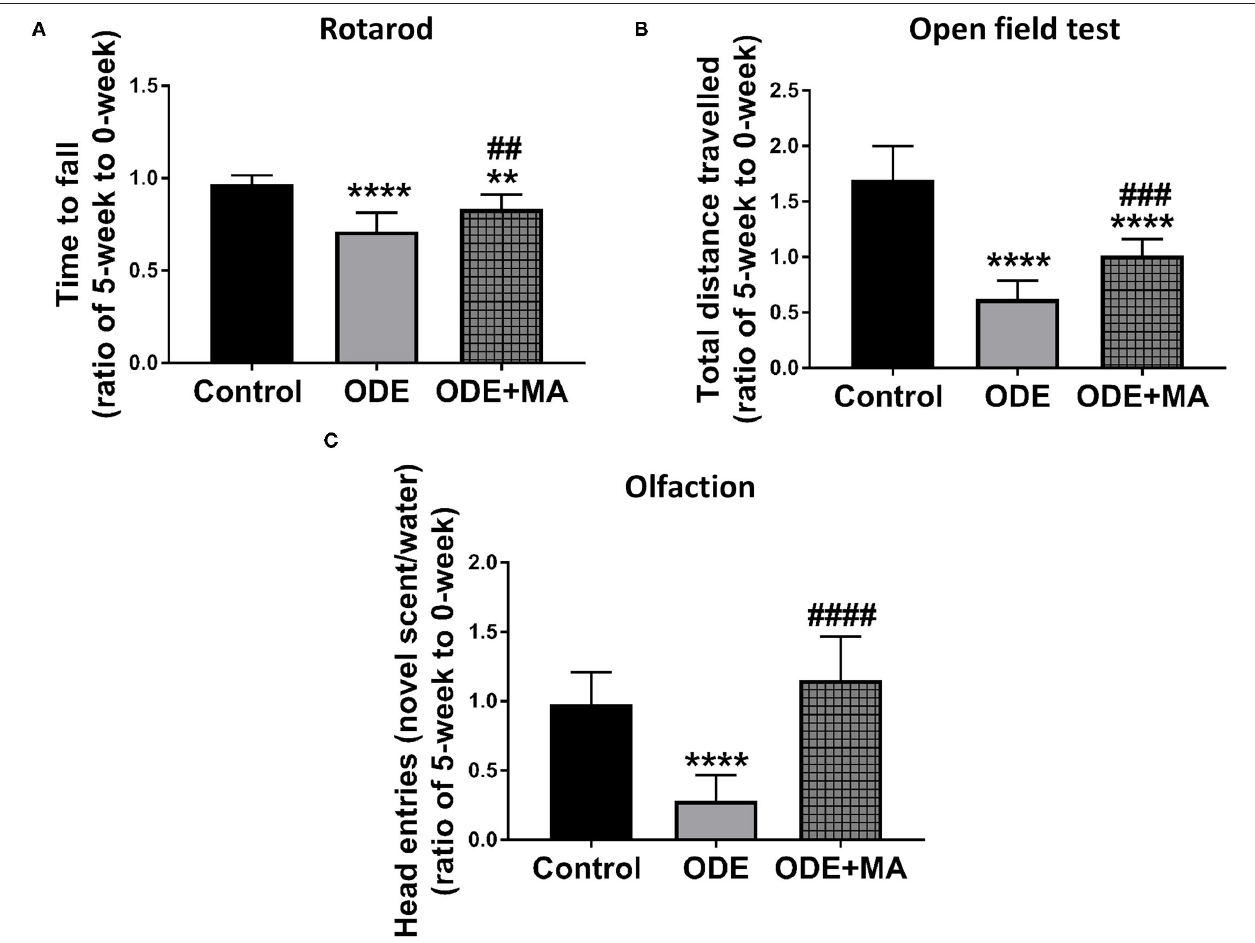
FIGURE 8 | ODE exposure induces neuro-motor and neuro-sensory changes in mice. As compared to control, ODE-exposed mice displayed a significant decrease in the time to fall from the rotarod in an accelerated profile, whereas mice administered with oral dosages of MA (C11) showed a significant higher time to fall from the rotarod when compared to ODE-exposed group (A) . As compared to control, ODE-exposed mice showed significantly lower exploratory locomotor activity. Whereas, mice administered with oral dosages of MA(C11) showed a significant higher exploratory locomotor activity when compared to ODE-exposed (B) . As compared to control, ODE exposed mice showed a significantly lower ability of olfactory sensation and mice administered with MA (C11) showed a significant higher sense of olfactory ability when compared to mice exposed to only ODE (C)